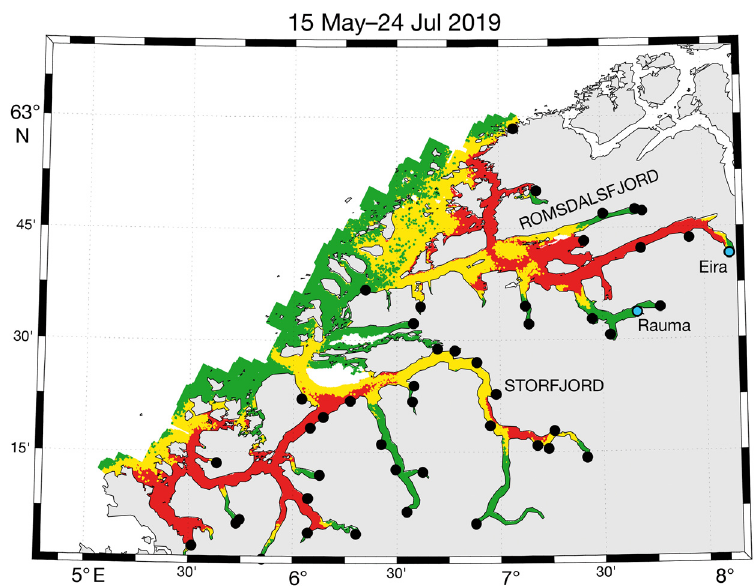
Fig. 3. ROC map of PO5 showing where it is expected that intermediate sea trout smolt migrants (remaining in the area from May 15 to July 24) are in- fested with >18 mobile lice (red area), between 6 and 18 mobile lice (yellow area) and <6 mobile lice (green area). The locations of the 47 sea trout rivers in the PO are marked with black dots, and the Eira and Rauma rivers are marked with cyan